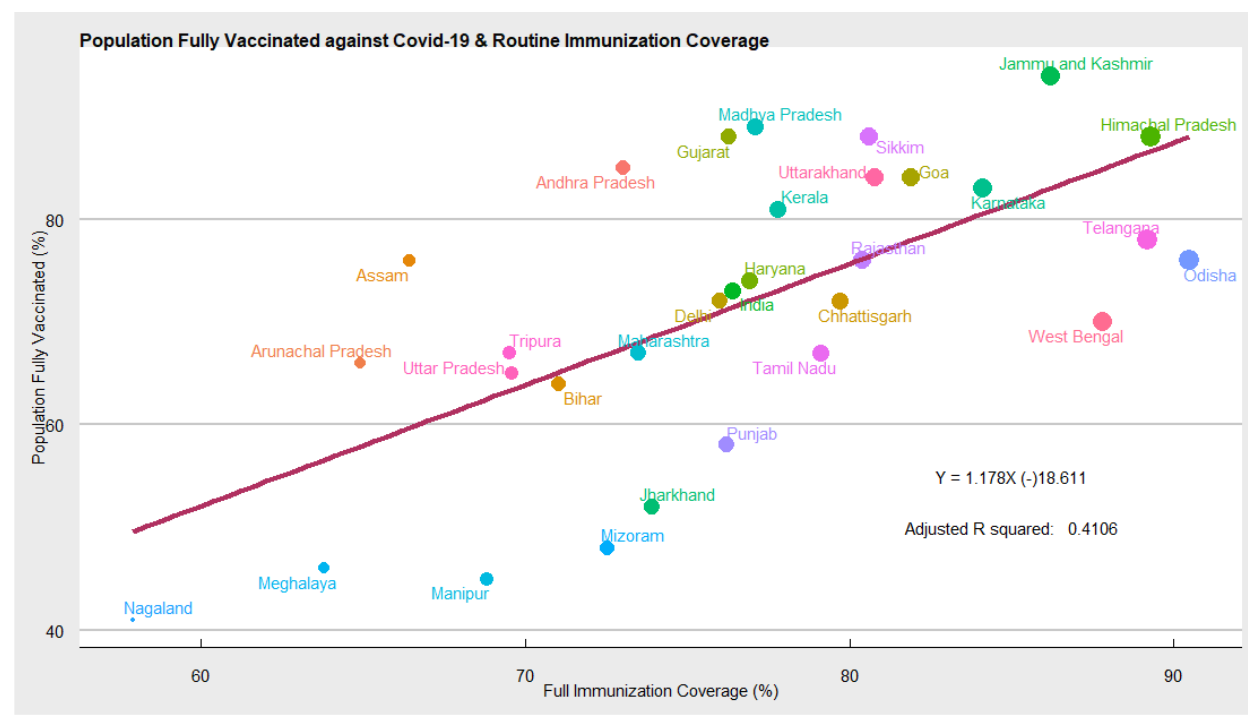
Figure 5. Scatter plot depicting routine immunisation and COVID-19 vaccination coverage.